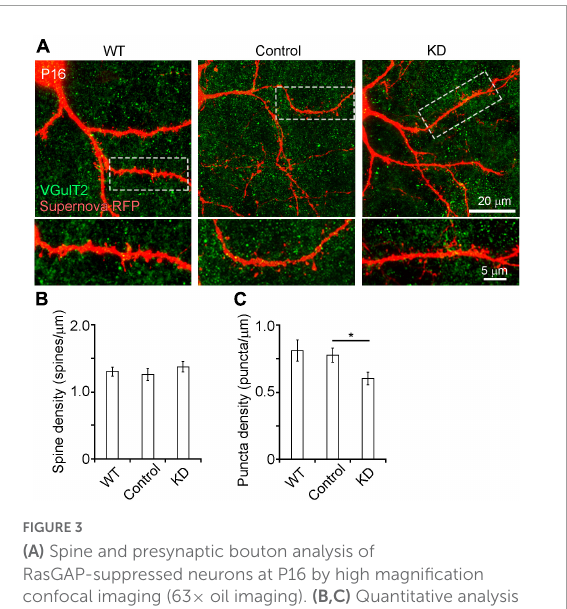
FIGURE3 (A) Spine and presynaptic bouton analysis of RasGAP-suppressed neurons at P16 by high magnification confocal imaging (63 × oil imaging). (B,C) Quantitative analysis of spine (B) and presynaptic bouton (C) density in secondary branches of L4 neuron dendrites located inside the barrels (WT, 28 branches from 8 mice; control, 22 branches from 13 mice; KD, 31 branches from 16 mice). * p <